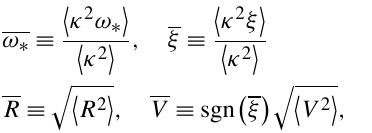
Figure 11. As in Fig. 1 but for trajectories of a noise dataset the same size as the original dataset. As described in the text, the noise is constructed on a trajectory-by-trajectory basis to have matching first- and second-order statistics as well as a similar velocity spec- trum, with the exception than the velocity spectrum is constrained to be isotropic. The heavy white contour is the